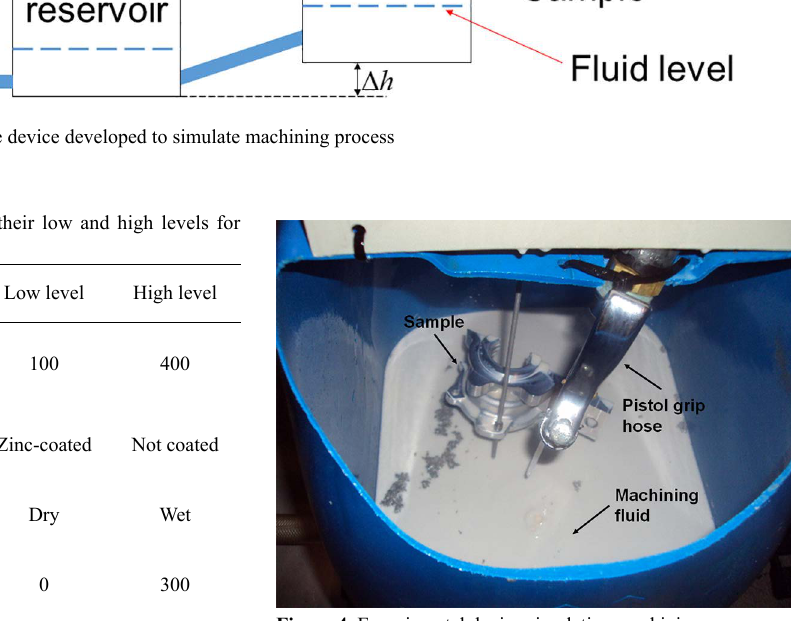
Figure 4. Experimental device simulating machining process